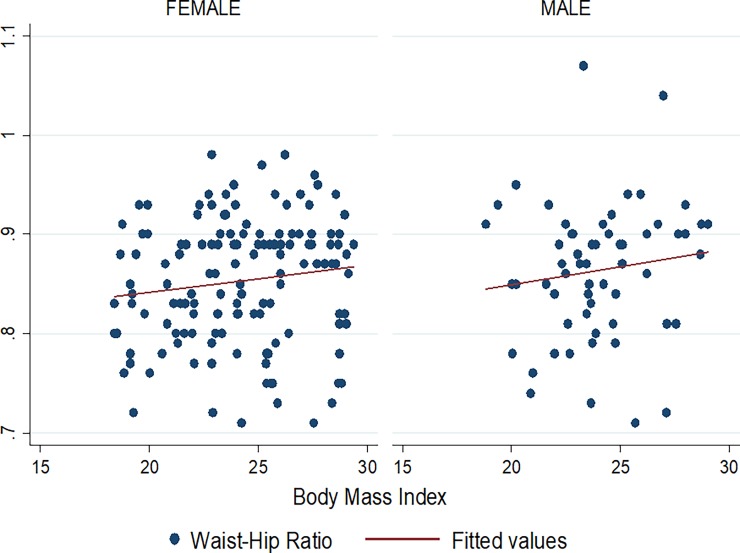
Linear regression model of the association between WHR and BMI in females and males.